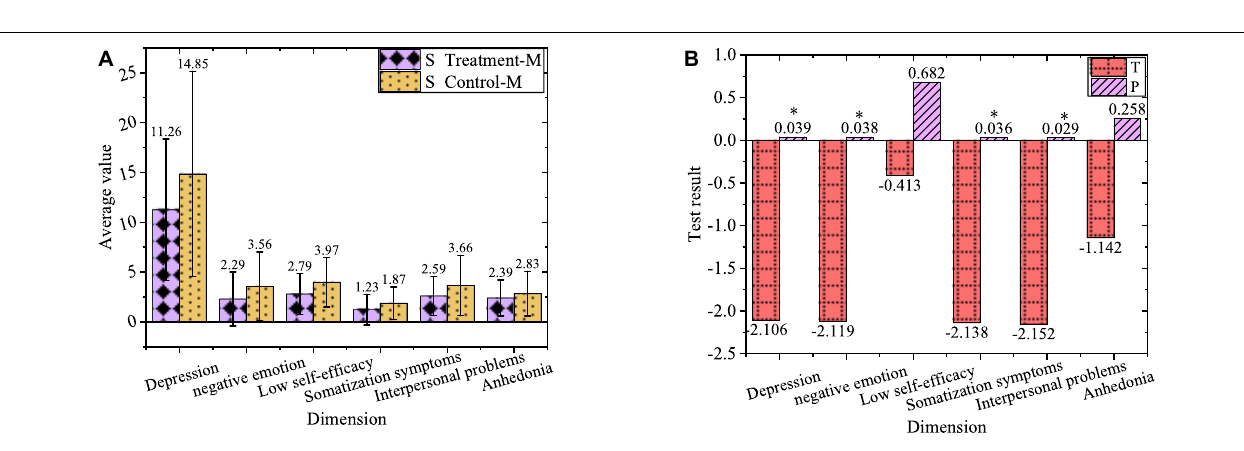
FIGURE 10 | Comparison of negative emotions. (A) Values of sophomores after the experiment. (B) Value of T and P of sophomores after the experiment. “ ∗ ”Refers to a significant difference, while “ ∗∗ ” represents a highly significant difference.